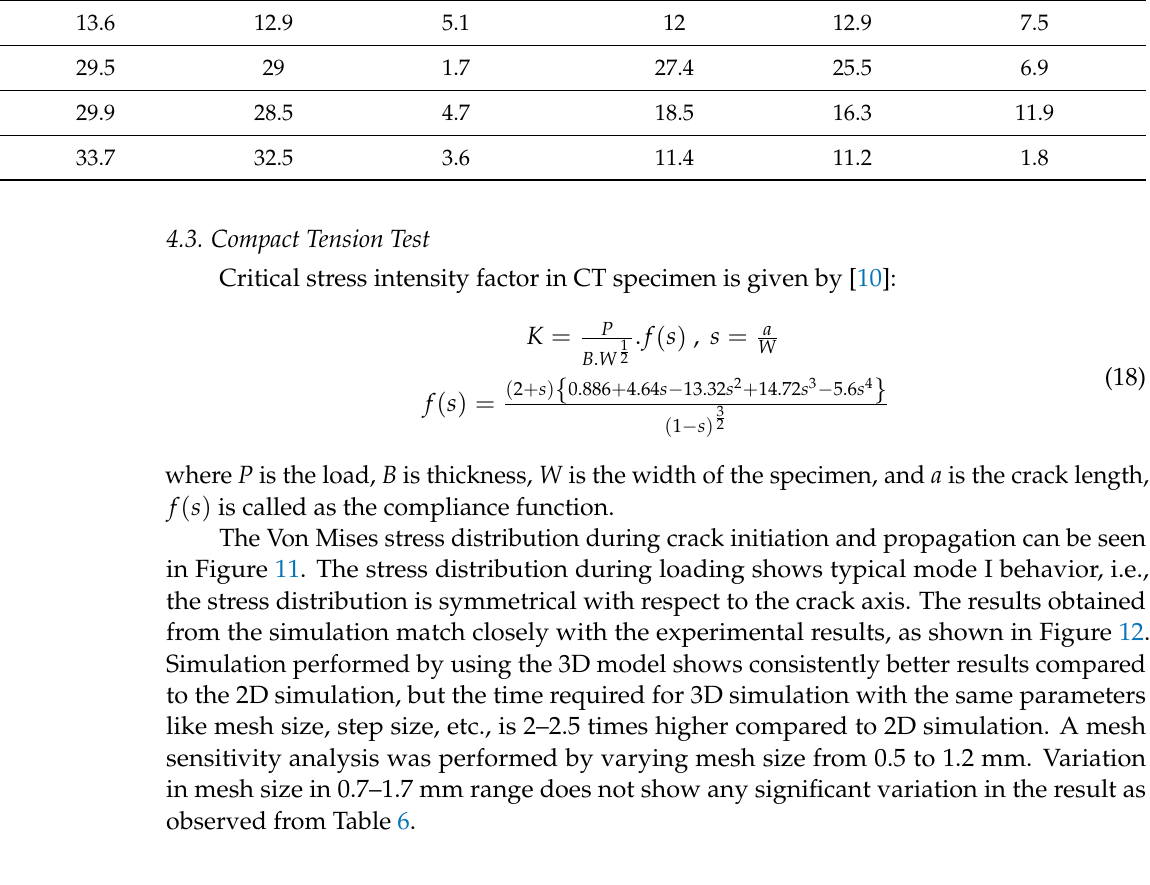
Table 5. Comparison of fracture toughness of 3PB specimen in experimental and simulated condition. Processing